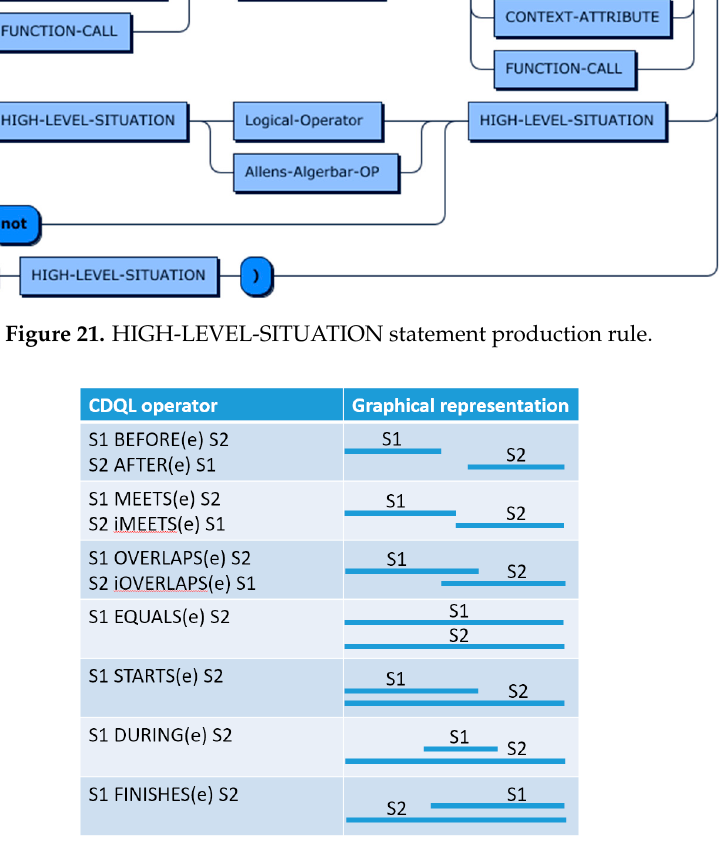
Figure 23. isValid function production rule.